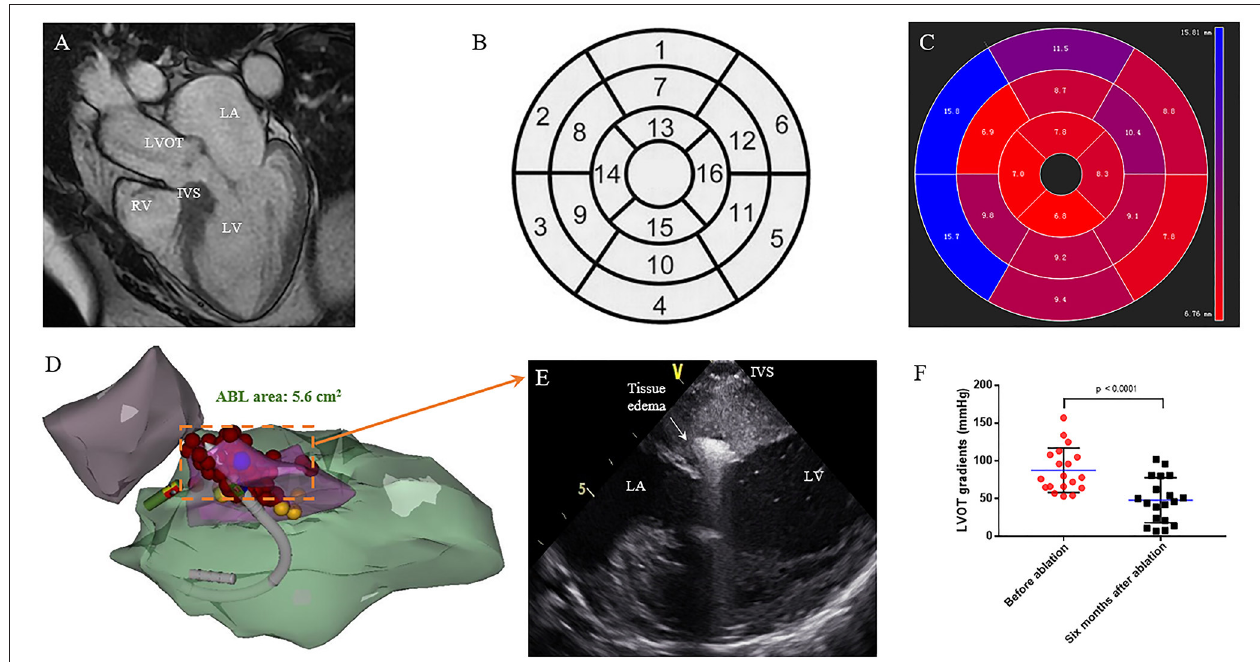
FIGURE 1 | Interventricular septal ablation in patients with HOCM. (A) CMR end-diastolic long-axis image demonstrates a significant hypertrophy in basal septum. (B) Display of the 16 myocardial segments on a circumferential polar plot. The recommended nomenclature for tomographic imaging of the heart: 1. Basal anterior, 2. Basal anteroseptal, 3. Basal inferoseptal, 4. Basal inferior, 5. Basal inferolateral, 6. Basal anterolateral, 7. Mid anterior, 8. Mid anteroseptal, 9. Mid inferoseptal, 10. Mid inferior, 11. Mid inferolateral, 12. Mid anterolateral, 13. Apical anterior, 14. Apical septal, 15. Apical inferior, 16. Apical lateral. (C) The circumferential polar plot presents a limited hypertrophy in basal anteroseptal and inferoseptal segments. The number indicates the average thickness of each segment. (D) Right anterior oblique (RAO) projection of the CARTO shell. Left ventricular (green), aorta (purple), SAM area of hypertrophic septum (pink), and left bundle branch (yellow) are presented. Ablation is performed on SAM area (red). (E) On the live ICE screen, significant tissue edema can be observed after ablation. (F) Reduction of obstruction at rest is seen on continuous-wave Doppler echocardiography. The LVOT gradient (in mmHg) is significantly decreased after 6 months follow up. ( P = 0.001) LA, left atrium; LV, left ventricle; LVOT, left ventricular outflow tract; RV, right ventricle; IVS, interventricular